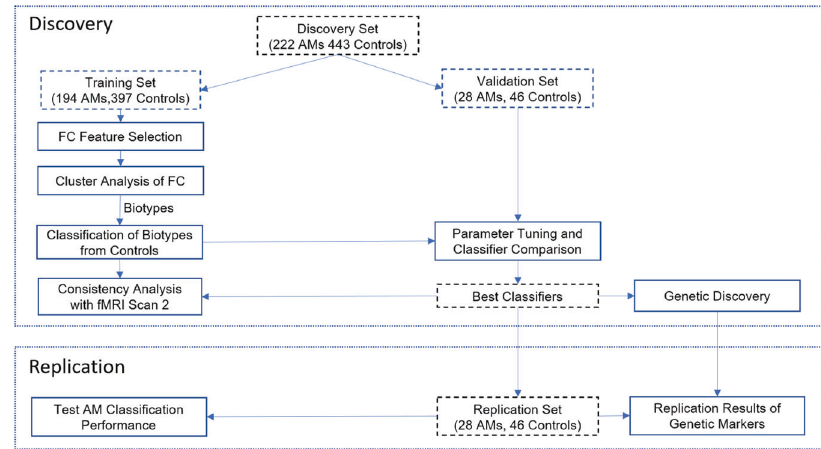
Fig. 1 The analytic pipeline to identify and validate alcohol misuse (AM)